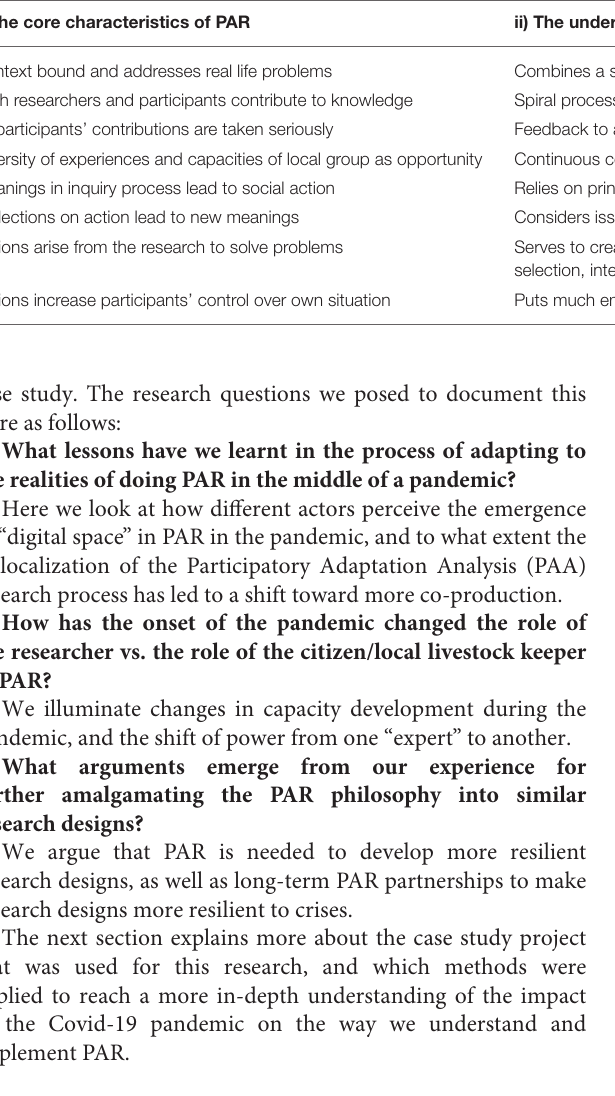
TABLE 1 | Analytical framework adapted from Burns